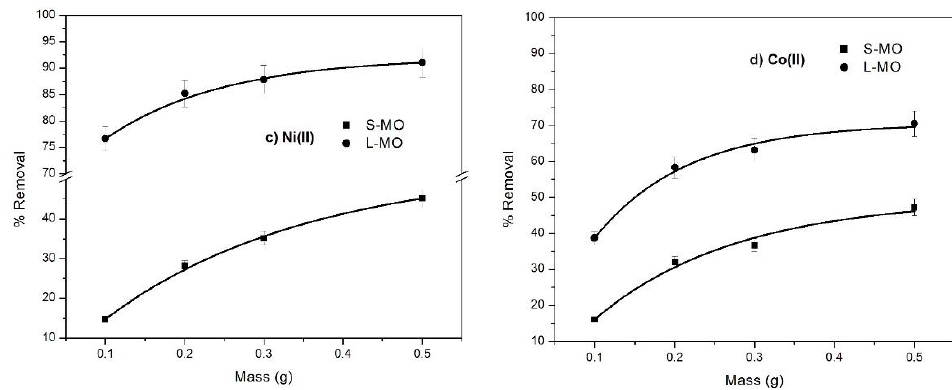
Figure 4. The effect of adsorbent dosage of S-MO and L-MO on the removal percentage of ( a ) Pb(II), ( b ) Cd(II), ( c ) Ni (II) and ( d ) Co(II) metallic ions at the following conditions: Ci = 100 mg/L; pH=6; and contact time = 300 min.